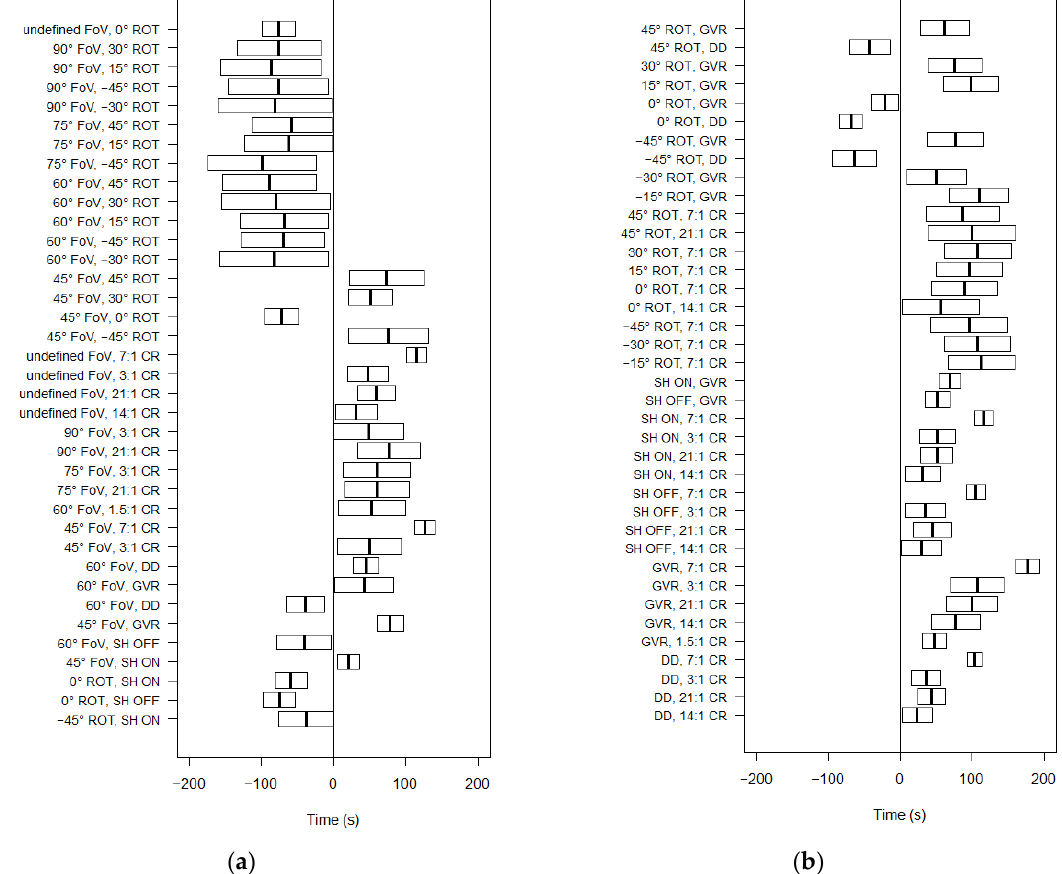
Figure 3. 95% CIs of each investigated significant pair of factors, graphically split into ( a , b ) for better readability.